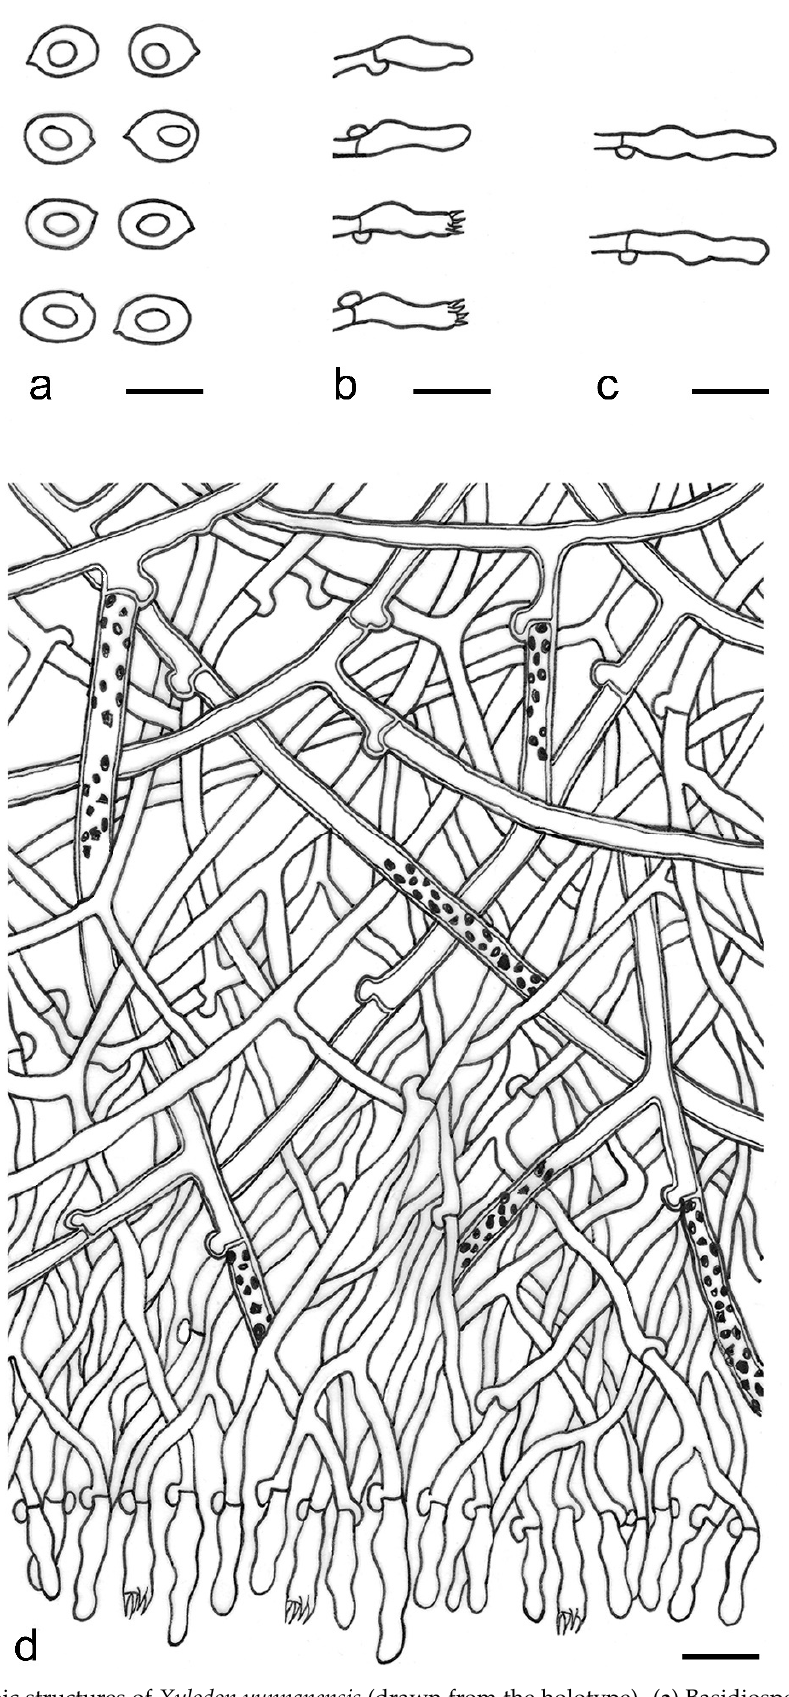
Figure 37. Microscopic structures of Xylodon yunnanensis (drawn from the holotype). ( a ) Basidiospores; ( b ) basidia and basidioles; ( c ) clavate to subclavate cystidia; ( d ) a section of the basidiocarp.—Scale bars: a = 5 μ m; b–d = 10 μ m.